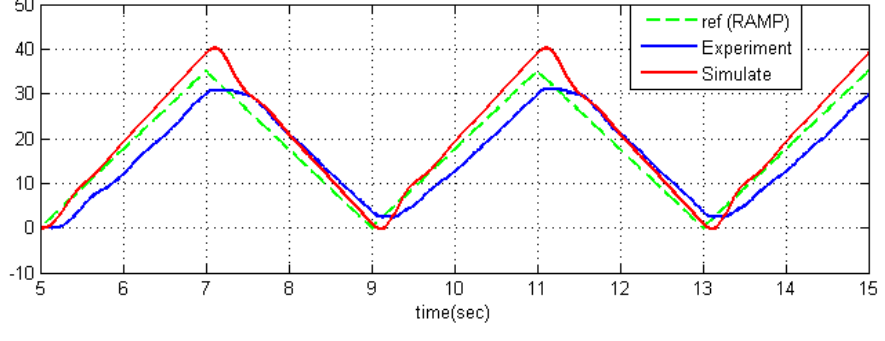
Figure 10. Controller response for ramp.